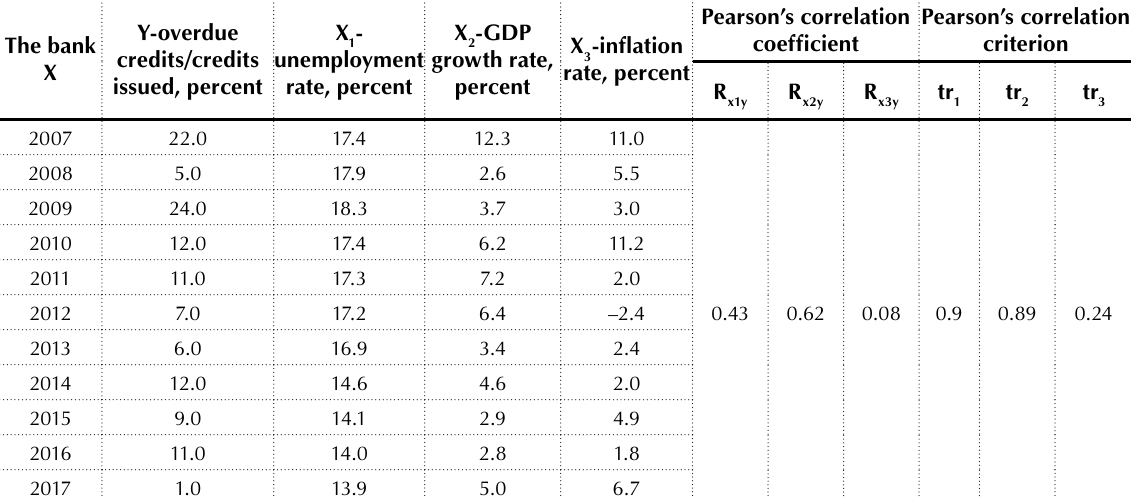
Table 1. The result of the calculation of Pearson’s correlation